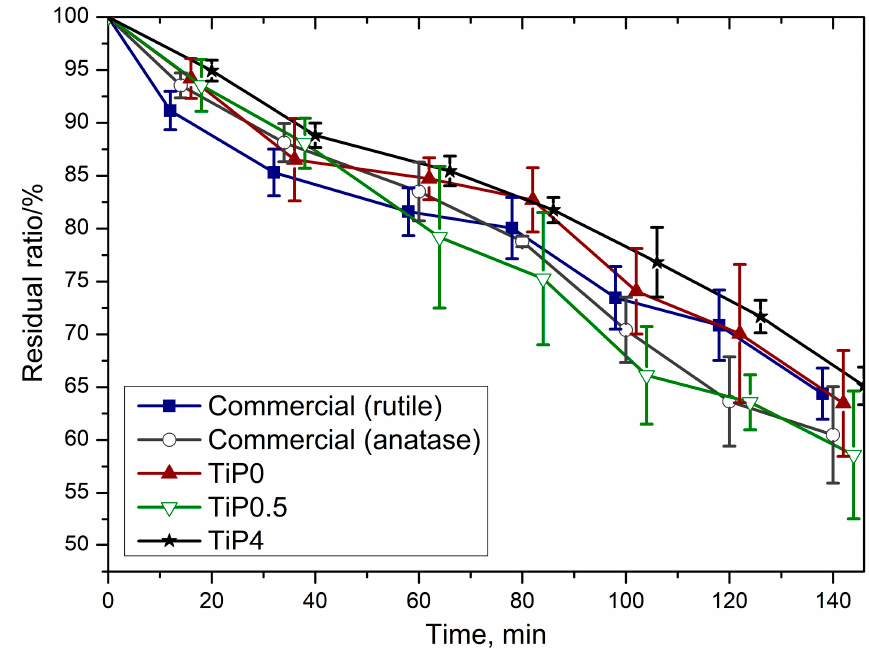
Figure 6. Moisture retention in the two commercial samples of TiO 2 and the experimental samples prepared in this study: TiP0 (brookite), TiP0.5 (anatase), and TiP4 (Ti 2 O 2 H(PO 4 )[(NH 4 ) 2 PO 4 ] 2 ).